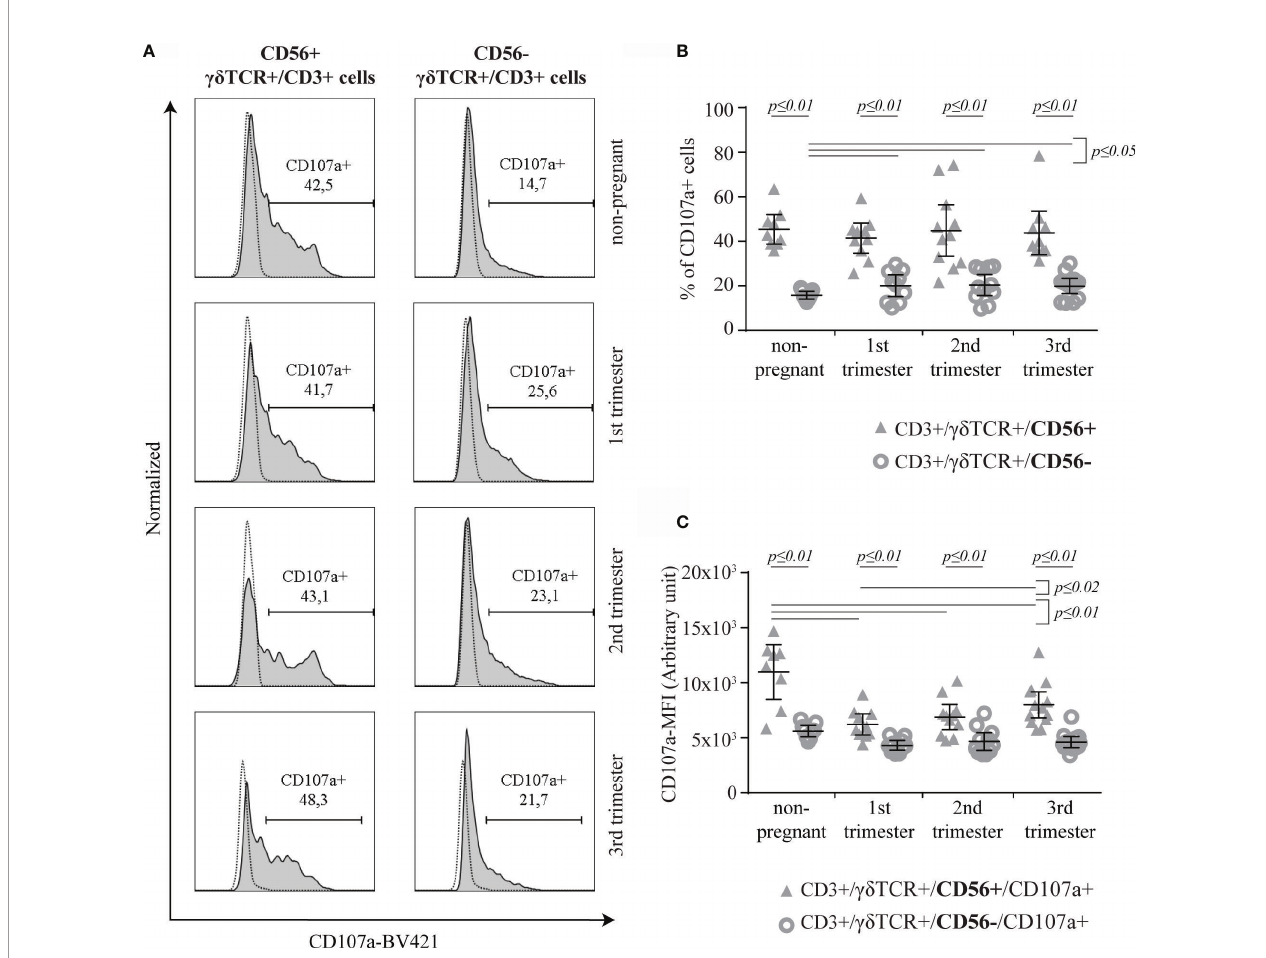
FIGURE 3 | Representative CD107a histograms (the FMO is depicted by the dotted line) of peripheral blood CD56+ or CD56 − gd T cells (CD3+/ gd TCR+) in non- pregnant and pregnant (1 st , 2 nd , and 3 rd trimester) women (A) Percentage (B) and Mean of Fluorescence Intensity (MFI) (C) of CD107a+ cells within peripheral blood CD56+ or CD56 − gd T cells (CD3+/ gd TCR+) in non-pregnant (n = 9) and pregnant [1 st (n = 10), 2 nd (n = 10), and 3 rd (n = 13) trimester] women. The mean is depicted by a horizontal line with the 95% con fi dence interval represented by whiskers. The individual data points are shown as triangles (CD3+/ gd TCR+/CD56+ or CD3+/ gd TCR+/CD56+/CD107a+, respectively) or circles (CD3+/ gd TCR+/CD56 − or CD3+/ gd TCR+/CD56 − /CD107a+, respectively). Statistical analysis was performed by using the Mann-Whitney test (non-pregnant vs 1 st trimester vs 2 nd trimester vs 3 rd trimester) or the Wilcoxon test (CD3+/ gd TCR+/CD56+ vs CD3+/ gd TCR+/CD56 − ). Signi fi cant differences are depicted by a horizontal line above the respective data